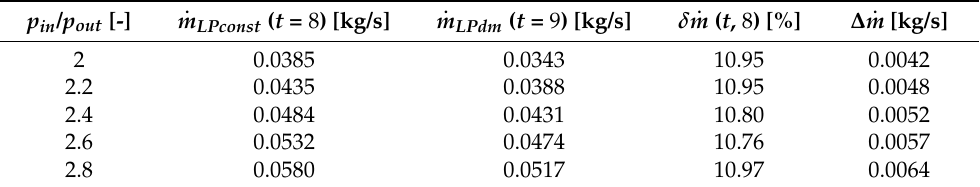
Table 6. Change of the leakage rate by Equations (17) and (18) depending on the pressure ratio p in /p out for the initial 8t and the designed geometry 9t of the staggered seal, RC = 0. 77 mm, T in = 300 K, p out = 10 5